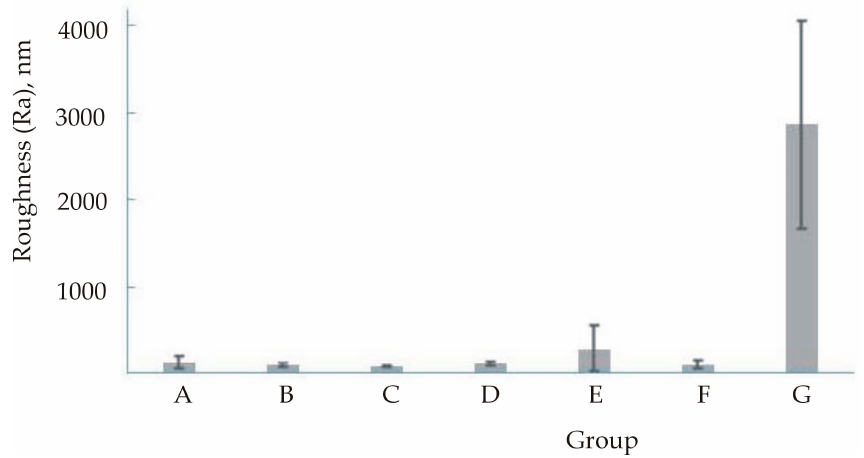
Figure 2. Mean value and standard deviation for roughness (Ra).